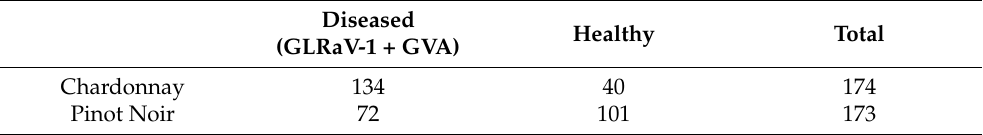
Table 1. ELISA test results for both cultivars.